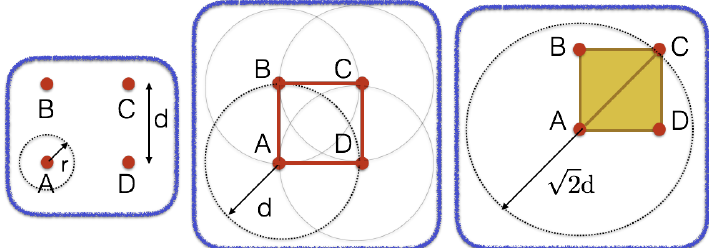
Figure 1. Illustrating TDA: ( left ) For r < d the four points (A, B, C and D) remain disconnected; ( center ) At r = d the hole ABCD appear from the four edges AB, BC, CD and DA; ( right ) The just √ created hole persist until r = 2 d , value at which A connects with C and the two resulting triangles ABC and ACD cover the initial hole that disappears